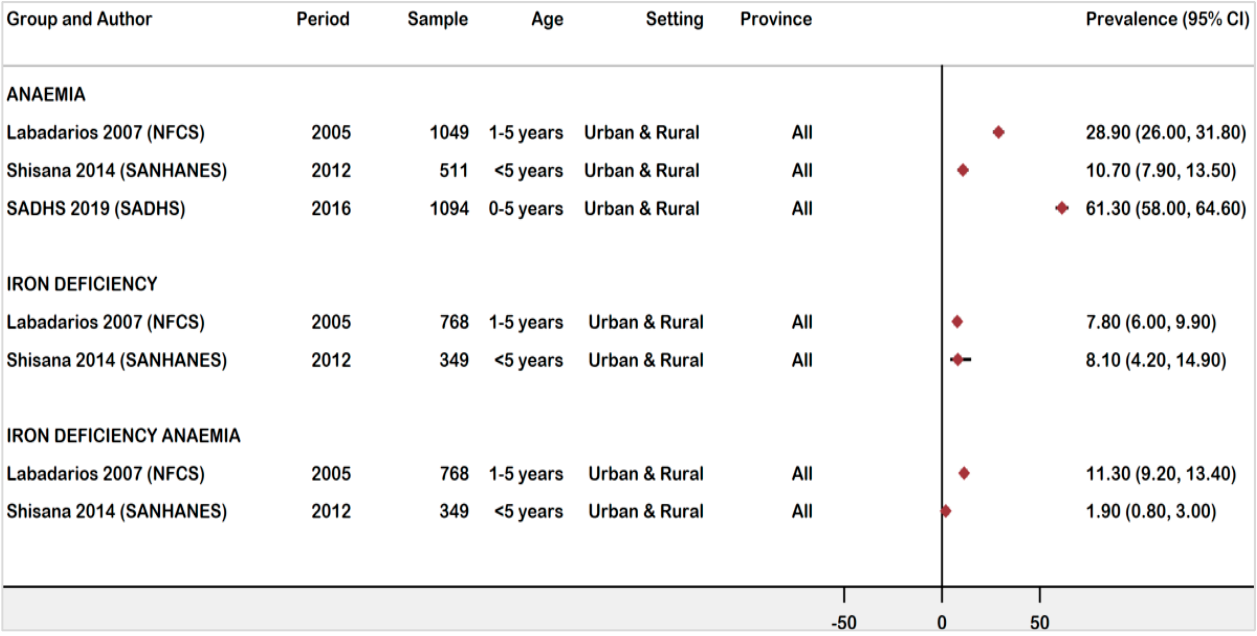
Figure 6. Forest plot of national prevalence of anaemia, ID, and IDA in children ages 0–5 years old in South Africa, 1997-2021.